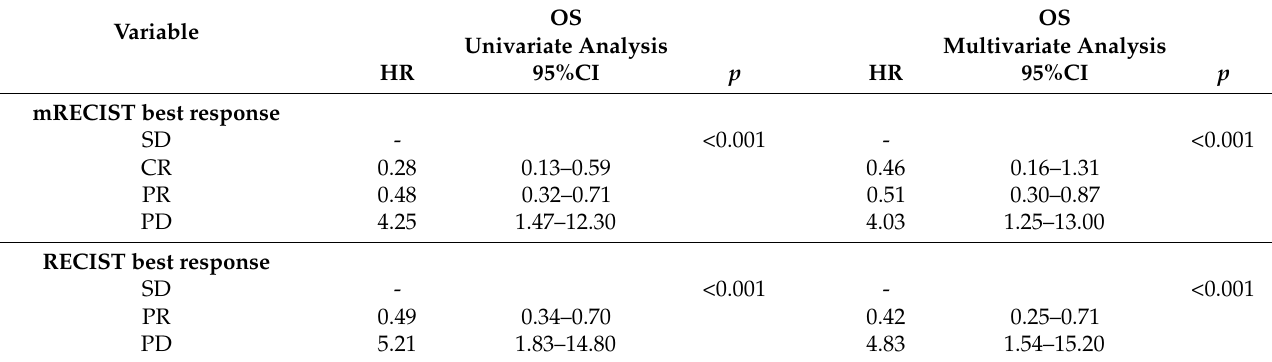
Table 4. Overall survival according to RECIST or mRECIST response status.